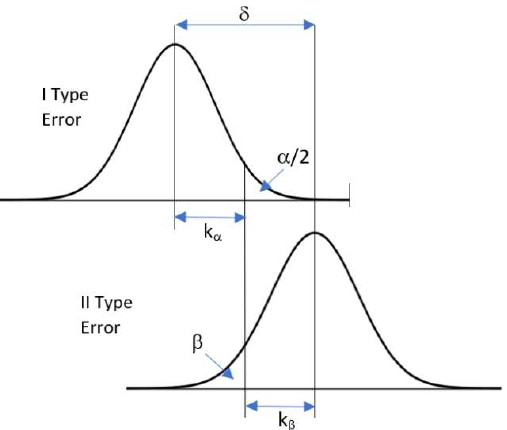
Figure 4. Graphical visualization of type I and II errors.